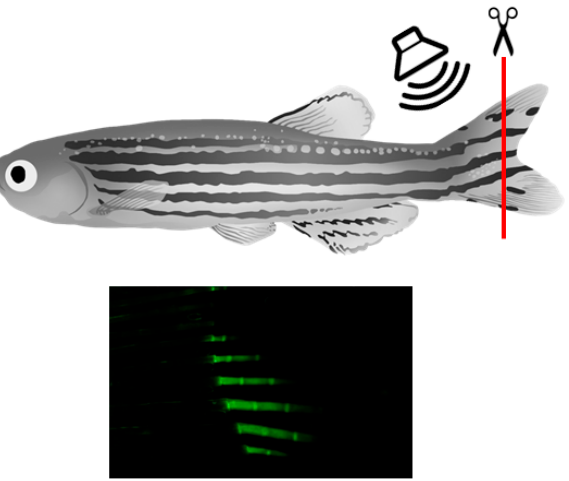
Figure 2. Fin amputation and double-live staining as readout model to study the effects of biophysical stimulations of bone regeneration in vivo. Different HI LF-PEMF treatments have been evaluated at five days after amputation in terms of duration or number of session, resulting in an effective protocol of 64 min twice a day (Figure 3).